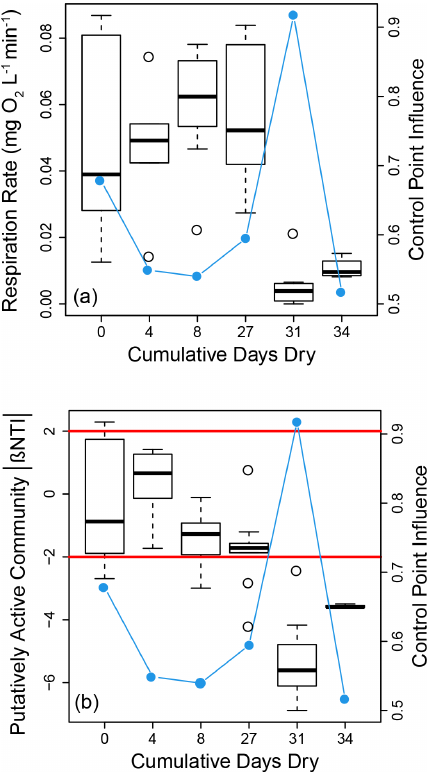
Figure 4. Boxplot representations of respiration rate (a) and pu- tatively active community β NTI (b) distributions as a function of the cumulative number of days reactors were in a dried state. Each value along the horizontal axis represents a different experimental treatment. On both panels the right hand axis provides estimates of control point influence (blue circles and lines) across the treat- ments. Horizontal red lines in (b) indicate significance thresholds; values below − 2 indicate deterministic homogenous selection, val- ues above + 2 indicate deterministic variable selection, and values between − 2 and + 2 indicate stochastic